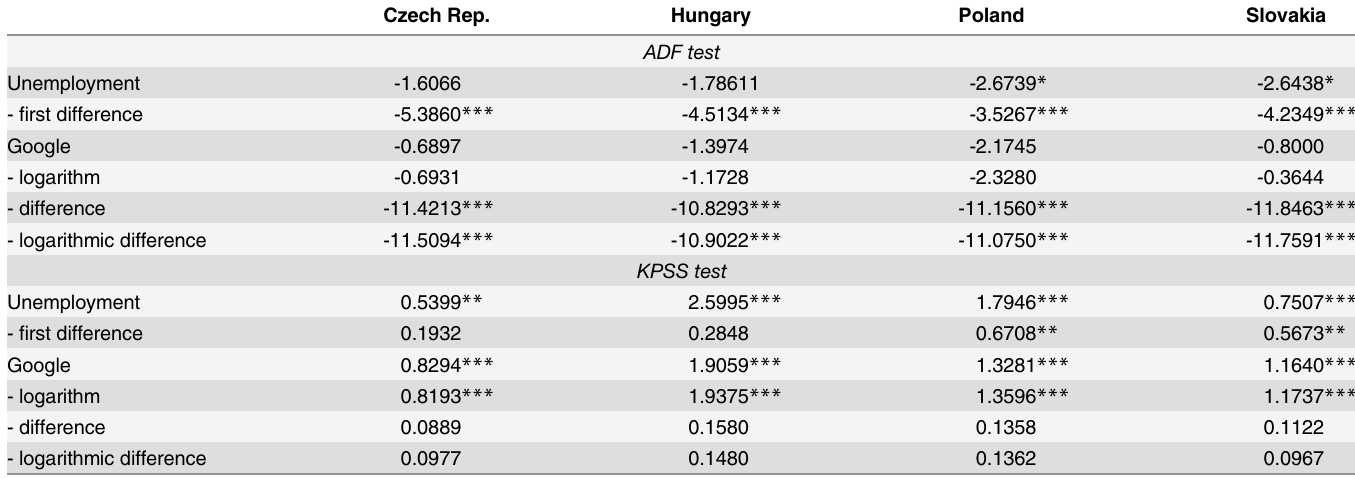
Table 2. Stationarity testing. Augmented Dickey-Fuller test (ADF) for a presence of unit root and KPSS test for stationarity are used. * , ** and *** stand for statistical significance at 10%, 5% and 1% levels, respectively. Number of lags for the tests is based on the Akaike Information Criterion (AIC) selection. Czech